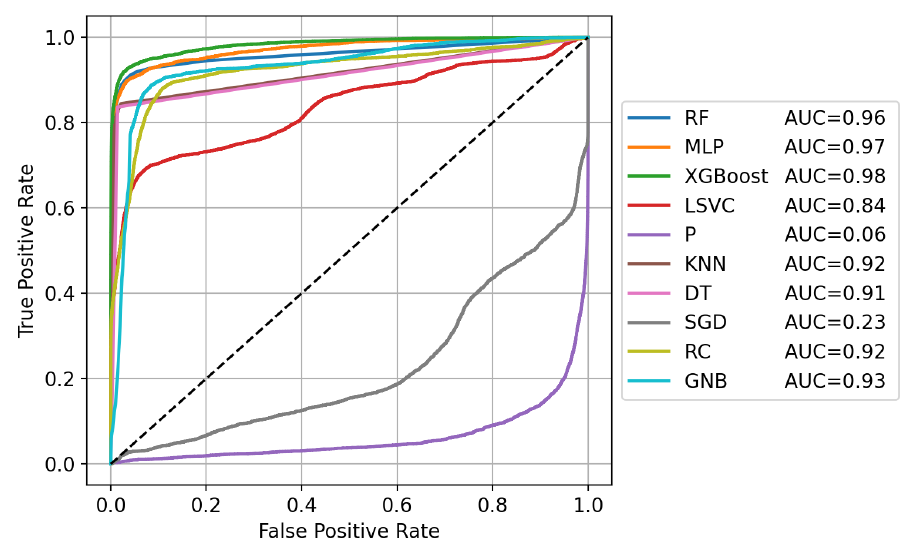
Figure 6. Receiver operating characteristic (ROC) curve for different machine learning algorithms. The black dashed line shows the performance of a random classifier. In the legend the area under the curve (AUC) is listed.